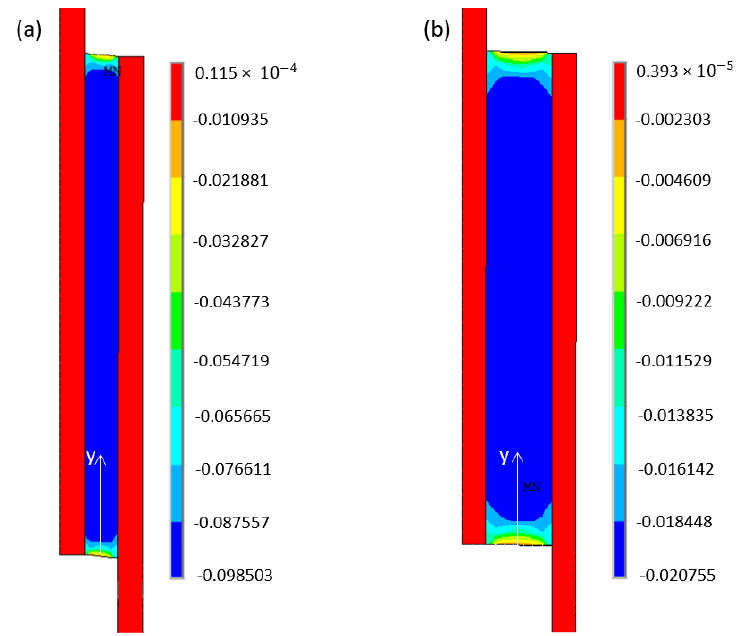
Figure 11. Shear strain field obtained by numerical simulation using the Mooney–Rivlin constitutive model. ( a ) 2 mm and ( b ) 4 mm of PDMS thickness.